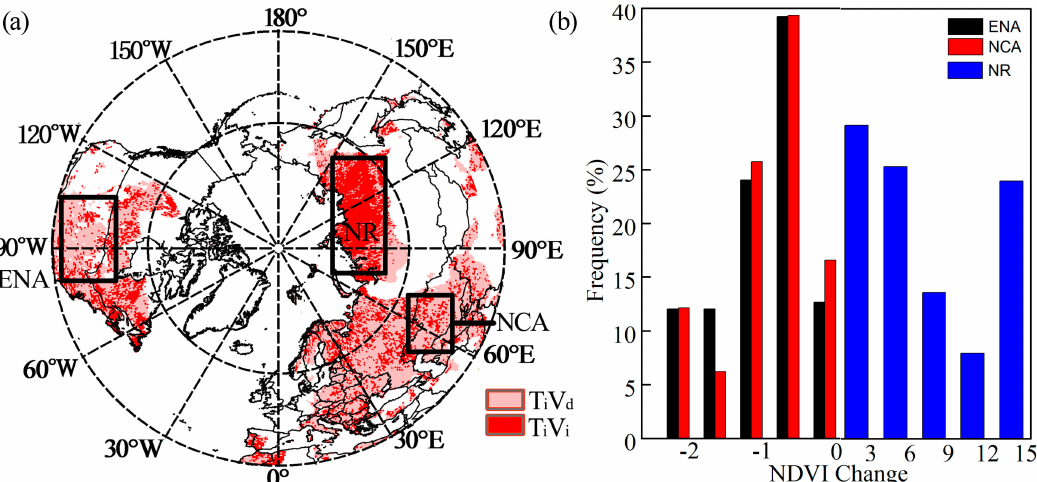
Figure 7. Spatial distribution of regions with ongoing warming. ENA: eastern North America; NR: northern Russia; NCA: northern central Asia. ( a ) Spatial distribution of regions without a warming hiatus in the middle-high latitudes of the NH. T i V i represents the increase in the NDVI in conjunction with ongoing warming. T i V d is the decrease in the NDVI in conjunction with ongoing warming; ( b ) Frequency distribution of the NDVI proportion in all